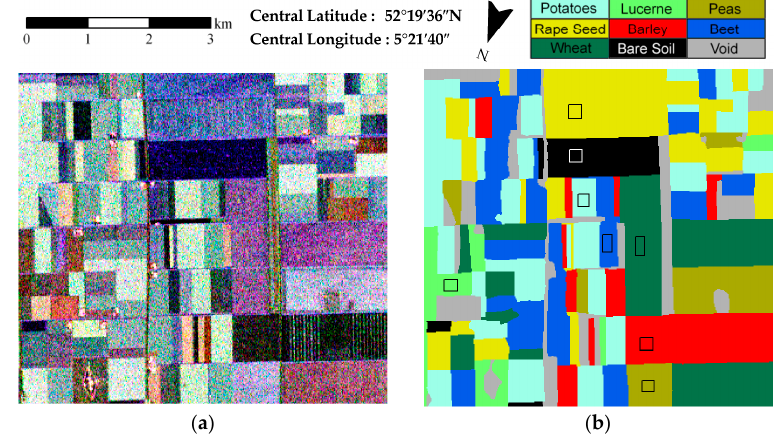
Figure 7. L-band, multi-look PolSAR image of Flevoland of AIRSAR as the third dataset used in the experiment: ( a ) Pauli color-coded image and ( b ) the ground truth map of ( a ). Boxes in ( b ) are the areas of training samples for the AIRSAR data.